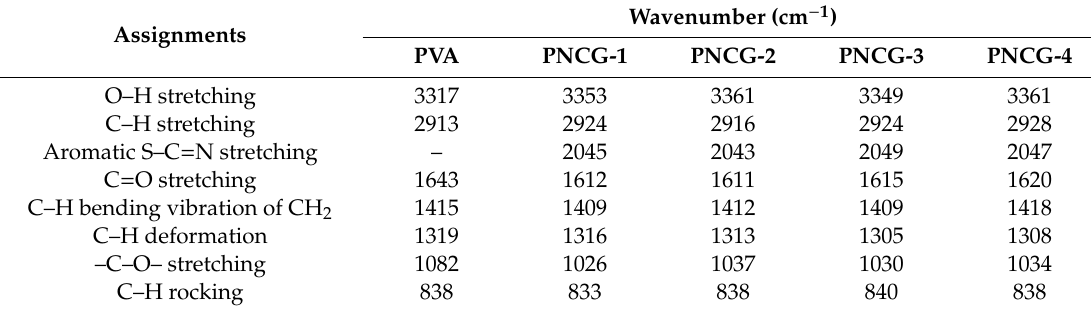
Table 2. The FTIR results of poly(vinyl alcohol) (PVA) and doped PVA.